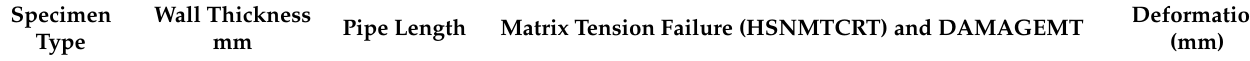
Table 7. Composite pipe matrix cracking and total deformation.